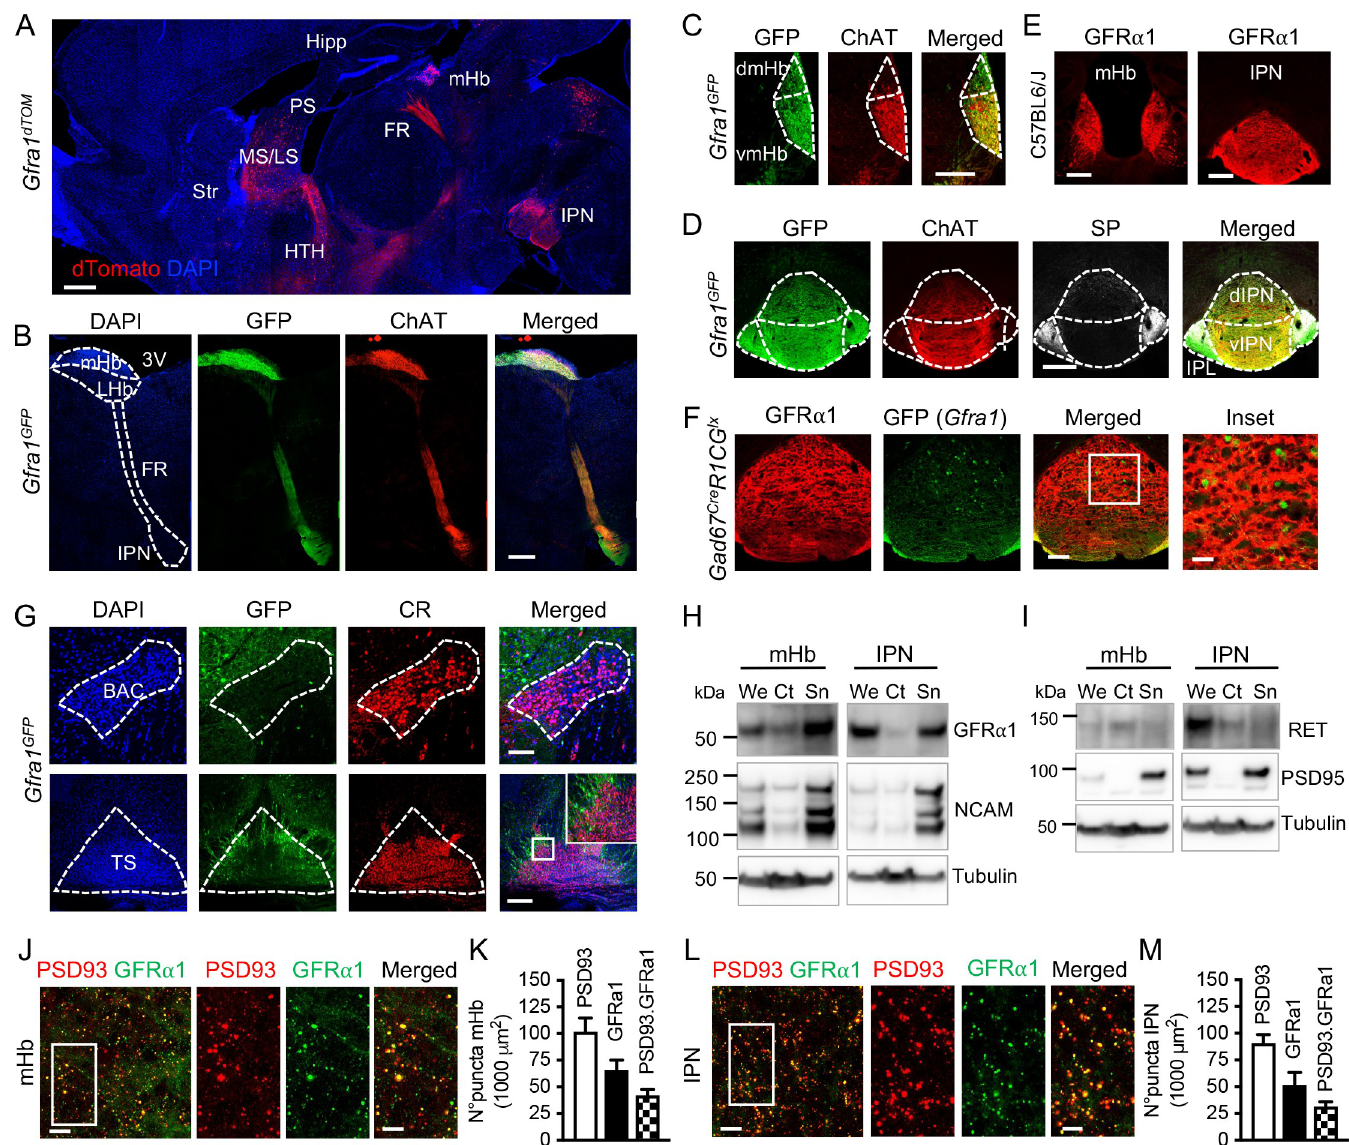
Fig 1. Characterization of GFR α 1 and co-receptor expression in neurons and synapses of the septum ! Hb ! IPN pathway. (A) dTomato epifluorescence (red) in sagittal sections of Gfra1 dTOM mouse brain injected with tamoxifen at 3 months counterstained with DAPI (blue). Scale bar, 500 μ m. (B) GFP (green) and ChAT (red) immunostaining in sagittal sections of a 3-month-old Gfra1 GFP mouse brain counterstained with DAPI (blue). Scale bar, 400 μ m. (C, D) GFP (green), ChAT (red), and SP (gray) immunostaining in coronal sections of the mHb (C) and IPN (D) of a 3-month-old Gfra1 GFP mouse brain. Scale bars, 200 μ m. (E) GFR α 1 immunostaining (red) in coronal sections of the mHb and IPN from a 3-month-old control (C57BL6/J) mouse. Scale bars, 200 μ m. (F) GFP (green) and GFR α 1 (red) immunostaining in a coronal section containing the IPN of a 3-month-old Gad67 Cre ;R1CG fx/fx mouse. GFP signal represents the GABAergic cells that express Gfra1 . Scale bars, 100 μ m (merged) and 35 μ m (inset). (G) GFP (green) and CR (red) immunostaining in coronal sections of the BAC and TS from a 3-month-old Gfra1 GFP mouse brain counterstained with DAPI (blue). Scale bars, 100 μ m (BAC) and 200 μ m (TS). (H, I) Immunoblots of We, Ct, and Sn protein extracts from the mHb and IPN of 3-month-old C57BL6/J mice probed for GFR α 1 and NCAM (H) or RET and PSD95 (I). Tubulin was probed as loading control. (J, M) GFR α 1 (green) and PSD93 (red) immunostaining in the mHb (J) and IPN (L) of 3-month-old C57BL6/J mice. Scale bars, 10 μ m (merged) and 5 μ m (insets). Graphs show the quantification ( ± SEM) of GFR α 1, PSD93, and double-labeled puncta in mHb (K) and IPN (M). N = 5 mice (25–30 images per mouse per structure). The data underlying this figure can be found at https://figshare.com/projects/Raw_Data_Fernandez-Suarez_et_al_2021/123406. 3V, 3th ventricle; ChAT, choline acetyltransferase; CR, calretinin; Ct, cytosolic protein fraction; dIPN, dorsal interpeduncular nucleus; dmHb, dorsal medial habenula; FR, fasciculus retroflexus; GFR α 1, glial cell–derived neurotrophic factor receptor alpha 1; Hipp, hippocampus; HTH, hypothalamus; IPL, lateral interpeduncular nucleus; IPN, interpeduncular nucleus; LHb, lateral habenula; LS, lateral septum; mHb, medial habenula; MS, medial septum; NCAM, neural cell adhesion molecule; PSD, postsynaptic density; Sn, synaptosome protein fraction; SP, substance P; Str, striatum; vIPN, ventral interpeduncular nucleus; vmHb, ventral medial habenula; We, whole protein extract.